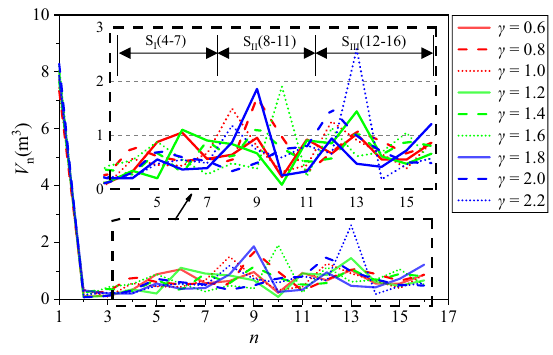
Fig. 10 The variation of V